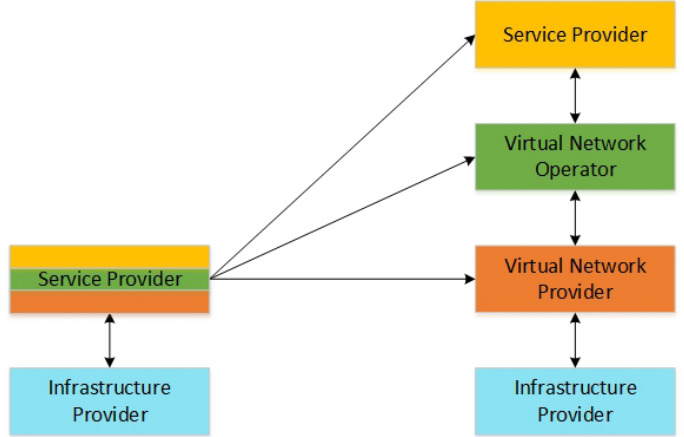
Figure 1. Revised Service Provider business